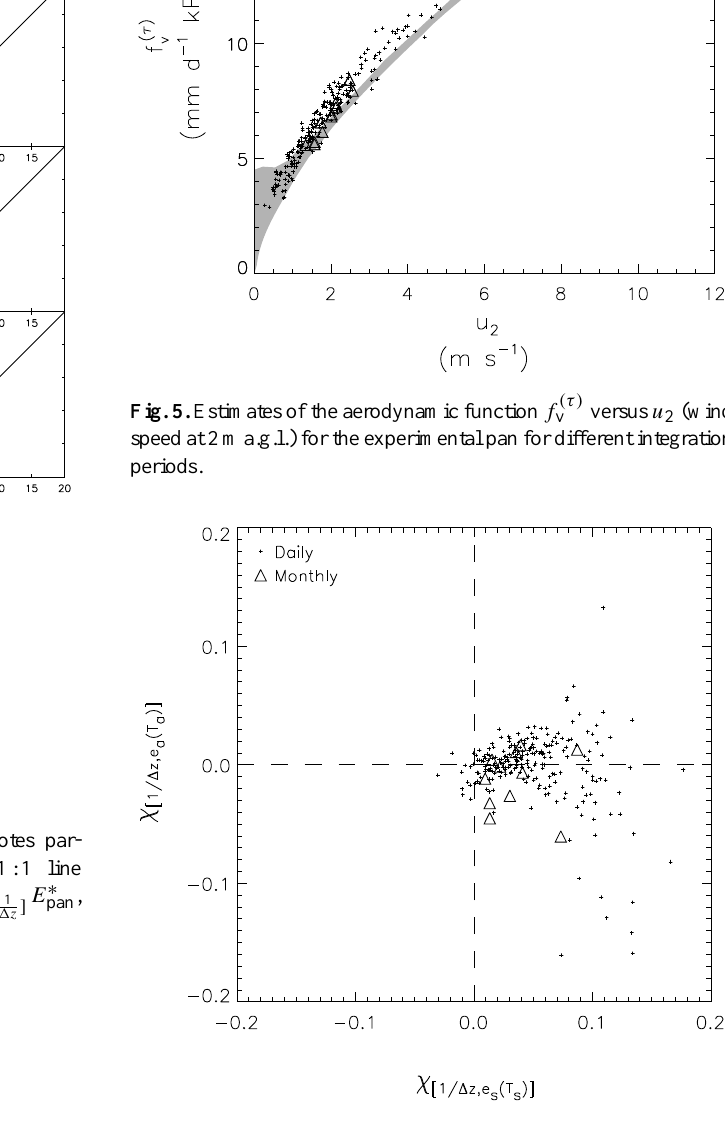
Fig. 6. Relation between the two key covariance-based correction factors for different integration